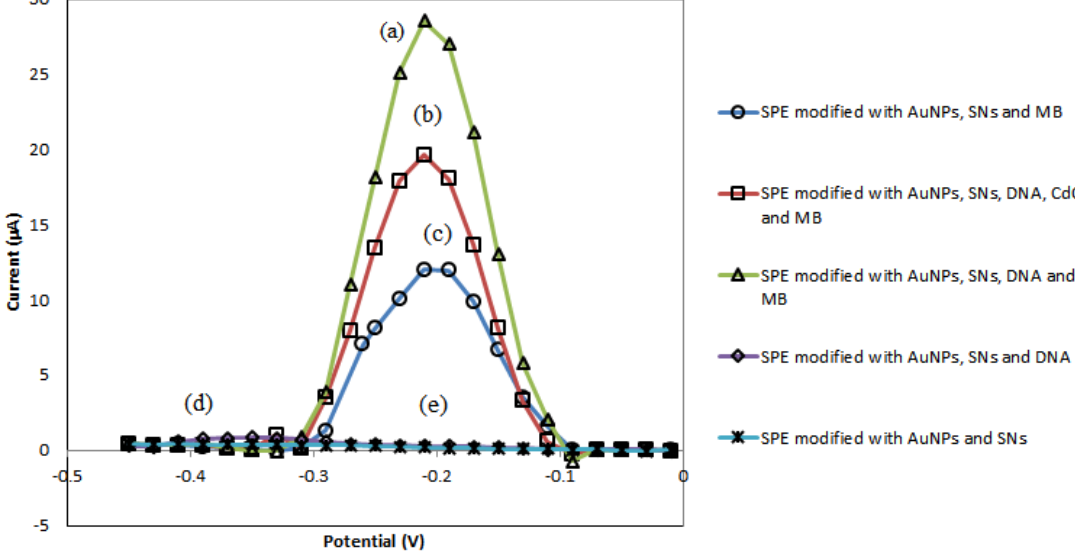
Figure 3. ( a ) SPE modified with AuNPs, silica nanospheres (SNs), DNA and MB. ( b ) SPE modified with AuNPs, SNs, DNA, cadmium chloride (CdCl) and MB. ( c ) SPE modified with AuNPs, SNs and MB. ( d ) SPE modified with AuNPs, SNs and DNA. ( e ) SPE modified with AuNPs and SNs.